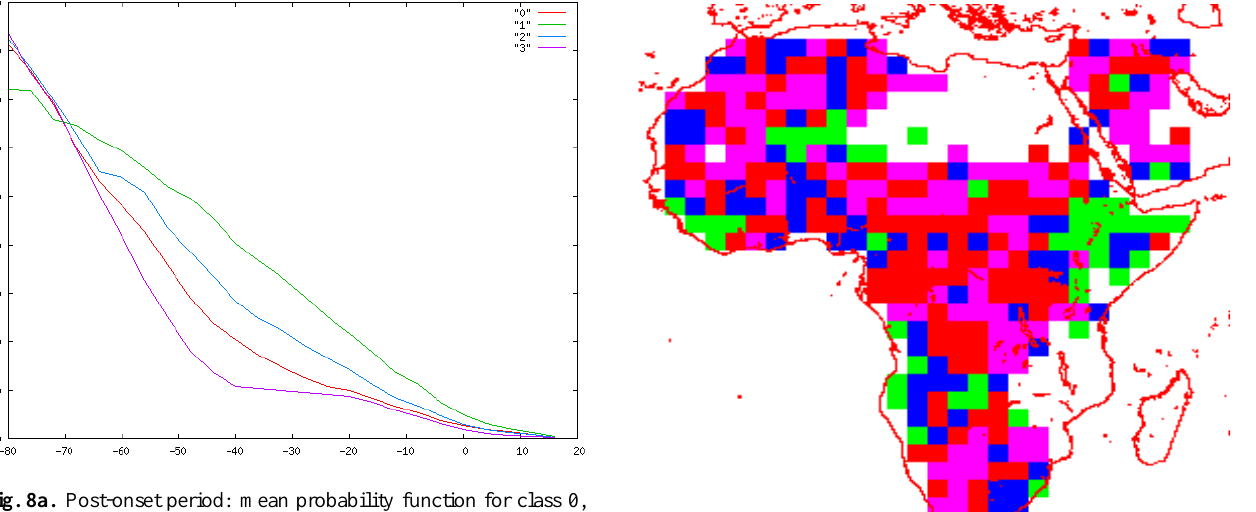
Fig. 8a. Post-onset period: mean probability function for class 0, Figure 8.a. Post-onset period: mean probability function for class 0, 1, 2 and 3. Although this 1, 2 and 3. Although this classification is independent from the classification is independent from the previous one, color code is selected to get maximum similarity previous one, color code is selected to get maximum similarity with with Fig. 7.a. Temperature is coded in degree C. Fig. 7a. Temperature is coded in degree C. Fig. 8b. Post-onset period: Spatial repartition of the four classes Figure 8.b. Post-onset period: Spatial repartition of the four classes computed by non supervised computed by non supervised classification. Same color code as in Fig. classification. Same color code as in Fig. 8.a.